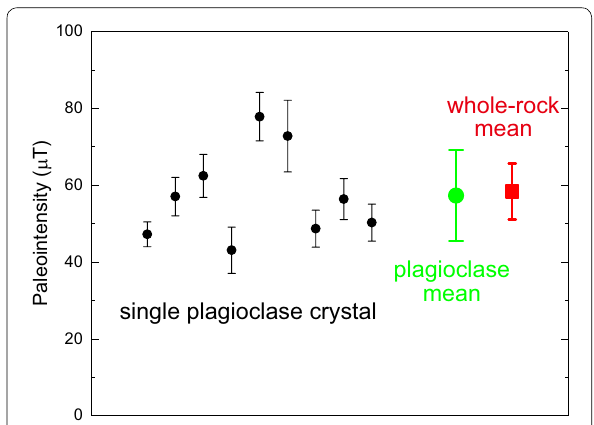
Fig. 11 Summary of paleointensity and error (1 σ ) of plagioclase compared with the whole rock. Black circles indicate results of each plagioclase grain. Green circle denotes the mean of nine plagioclase grains. Red square marks the mean of whole-rock measurements (Tsunakawa et al. 2009)